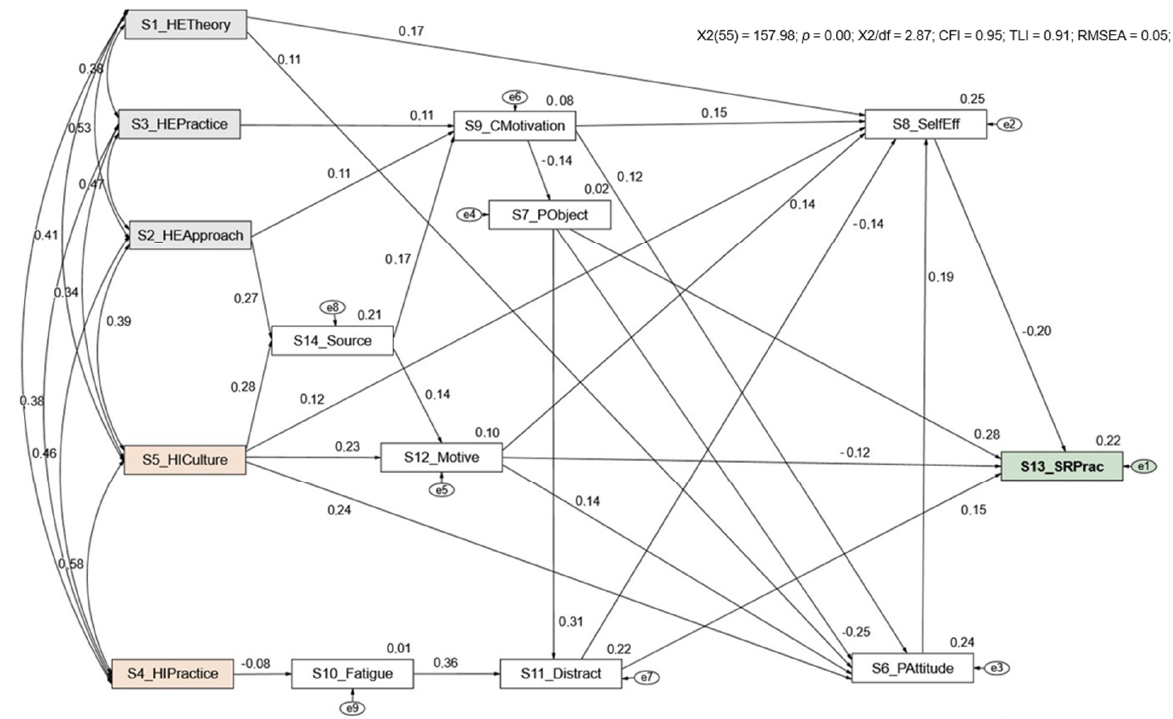
Figure 1. Multifactorial path analysis model of the standardized effect of factors determining the students self-reported HAI practices. Healthcare-associated infections